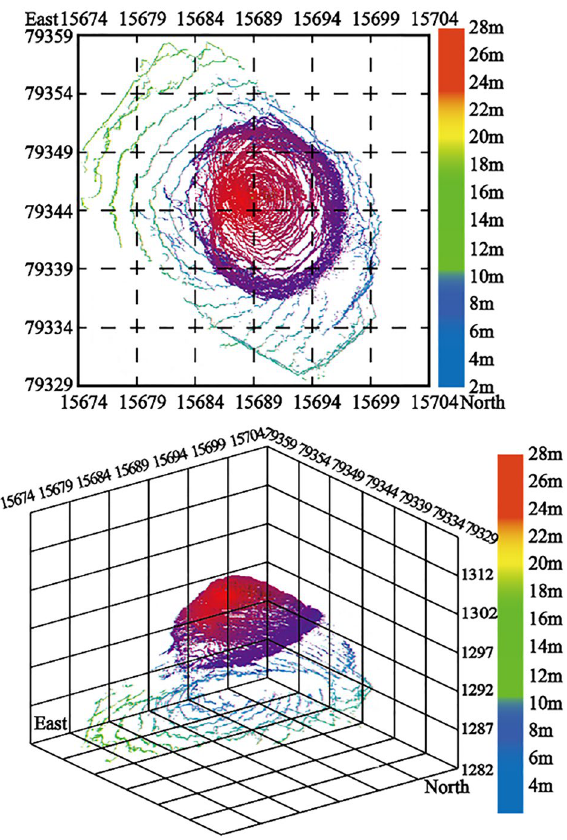
Figure 12. 1320 flat plate A-59 drilling 3d laser scanning 3D model. According to the results of three- dimensional laser scanning, the distance between the roof and the floor of the mined-out area is 25.6 m, the cavity volume of the mined-out area is about 3400m 3 , the minimum distance between the roof and the surface is 21 m, the short axis azimuth is 35.7, and the length of the mined-out area.The azimuth angle of the long axis is 129 and the length is about 28.5 m.